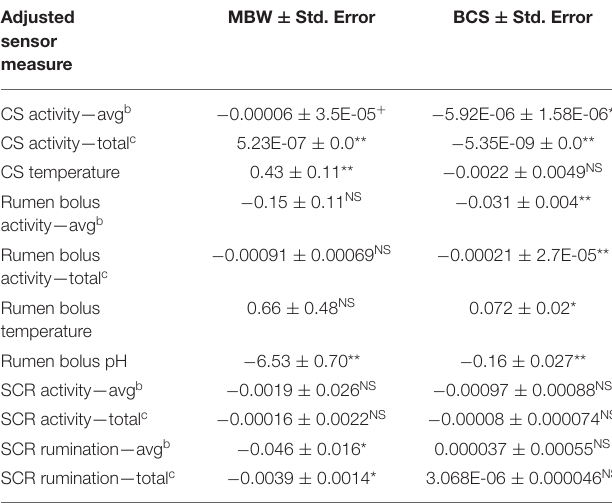
TABLE 4 | The association of sensor measures a with metabolic body weight (MBW = BW 0.75 ) and body condition score